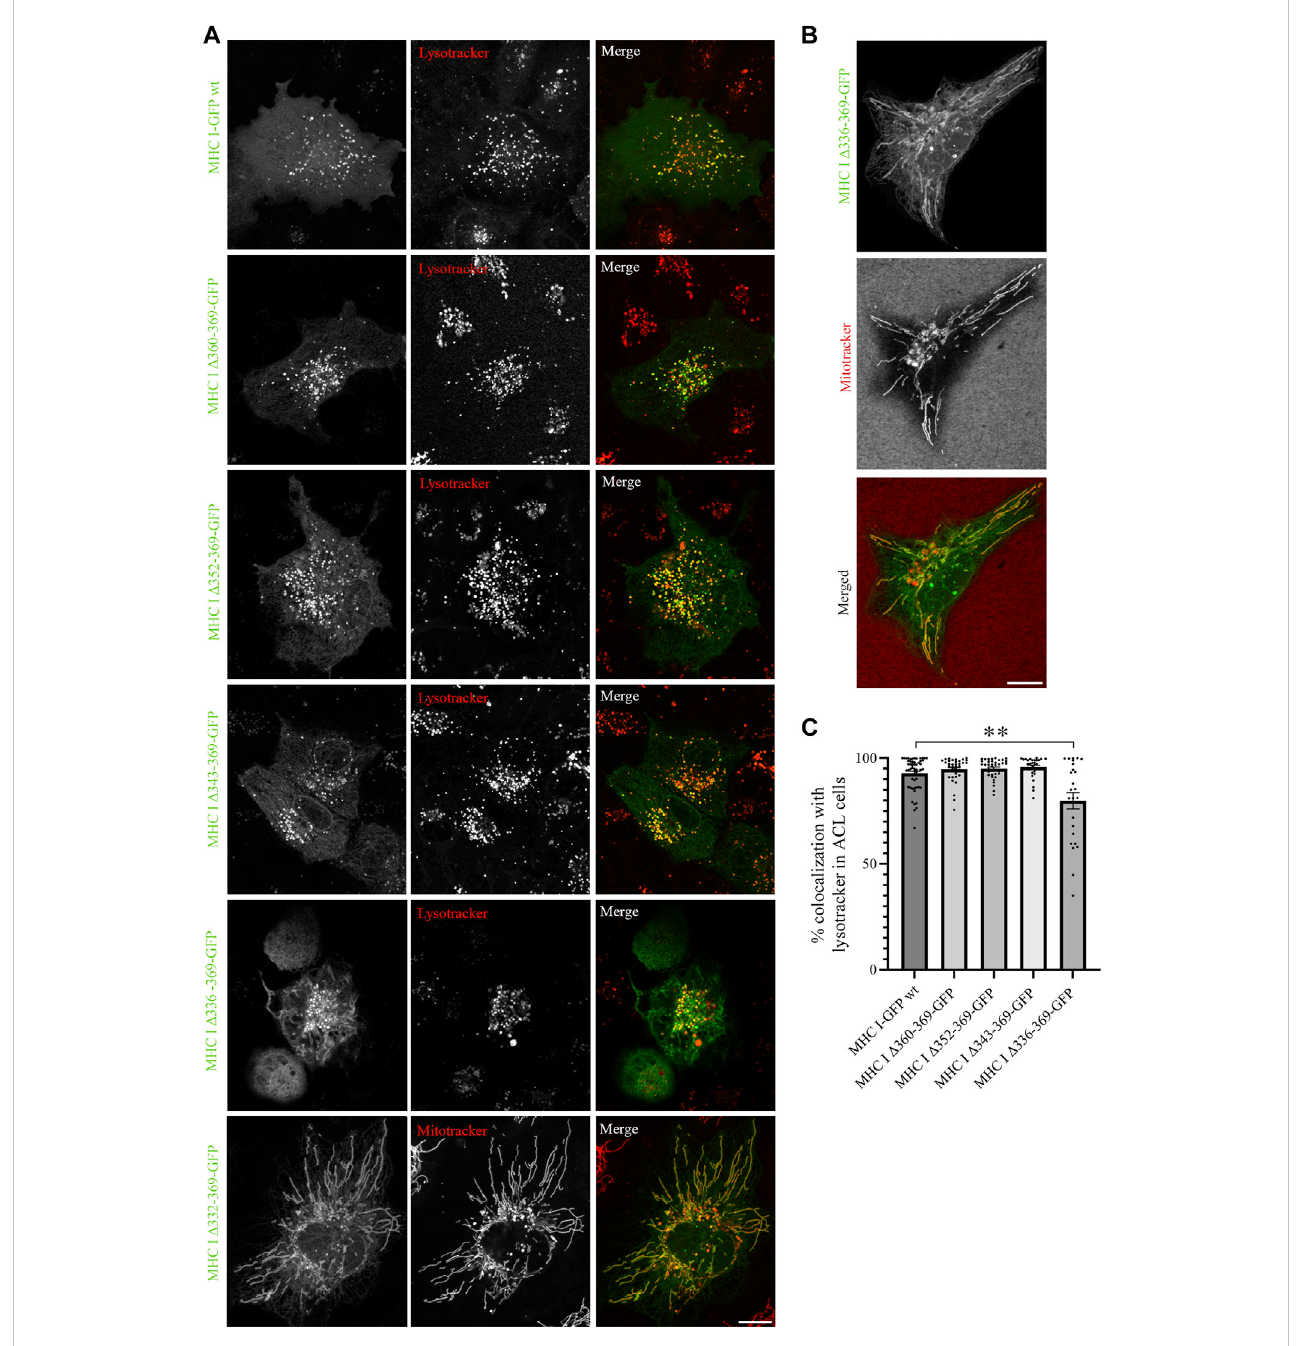
FIGURE 5 Cytosolic tail deletion mutants of Atlantic cod MHC I variant 1 relocate MHC I to mitochondria in ACL cells. (A, B) Representative images of ACL cells transiently transfected with Atlantic cod MHC I variant 1-GFP wt or the fi ve deletion mutants (green). The cells were stained with either lysotracker red or mitotracker deep red and imaged using a Zeiss LSM880 Fast AiryScan microscope. Colocalization between green and red channels results in yellow signal in the merged panels. Scale bar: 10 μ m. (C) The graph represents the percentage of colocalization between Atlantic cod MHC I variant 1 wt or the deletion mutants andlysotrackerred.Colocalizationwasdone byobject-based analysis usingImageJsoftware.Valuesrepresent themean±s.e.m. from atleastthree independent experiments. n ≥ 25 cells. ** p < 0.01 (Two-tailed paired Student t